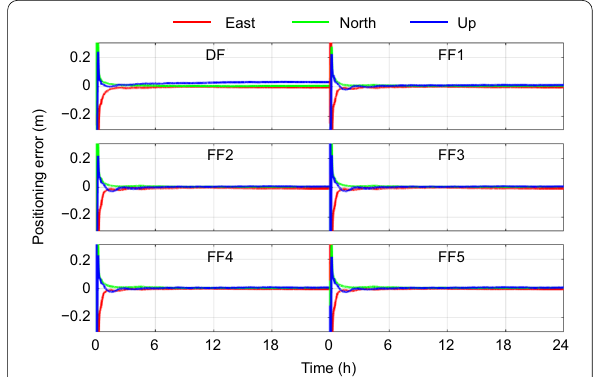
Fig. 3 Positioning error of static PPP solutions among different PPP models at station met3 (DOY 283, 2021)